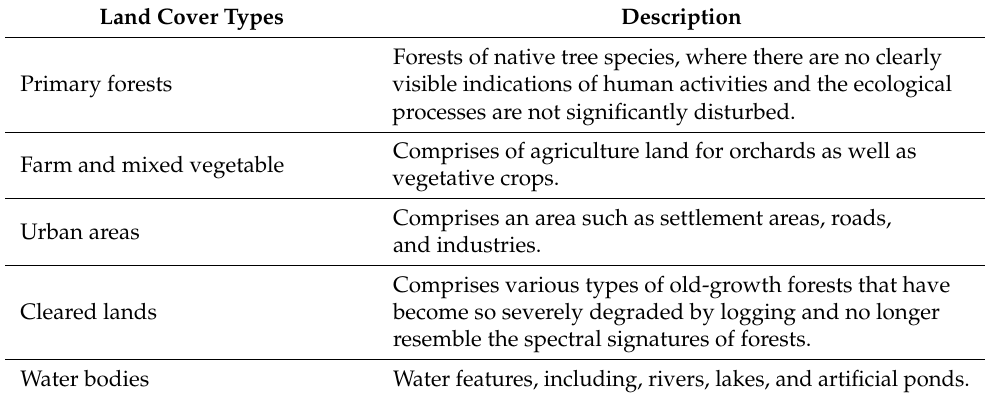
Table 2. Description of land use / cover